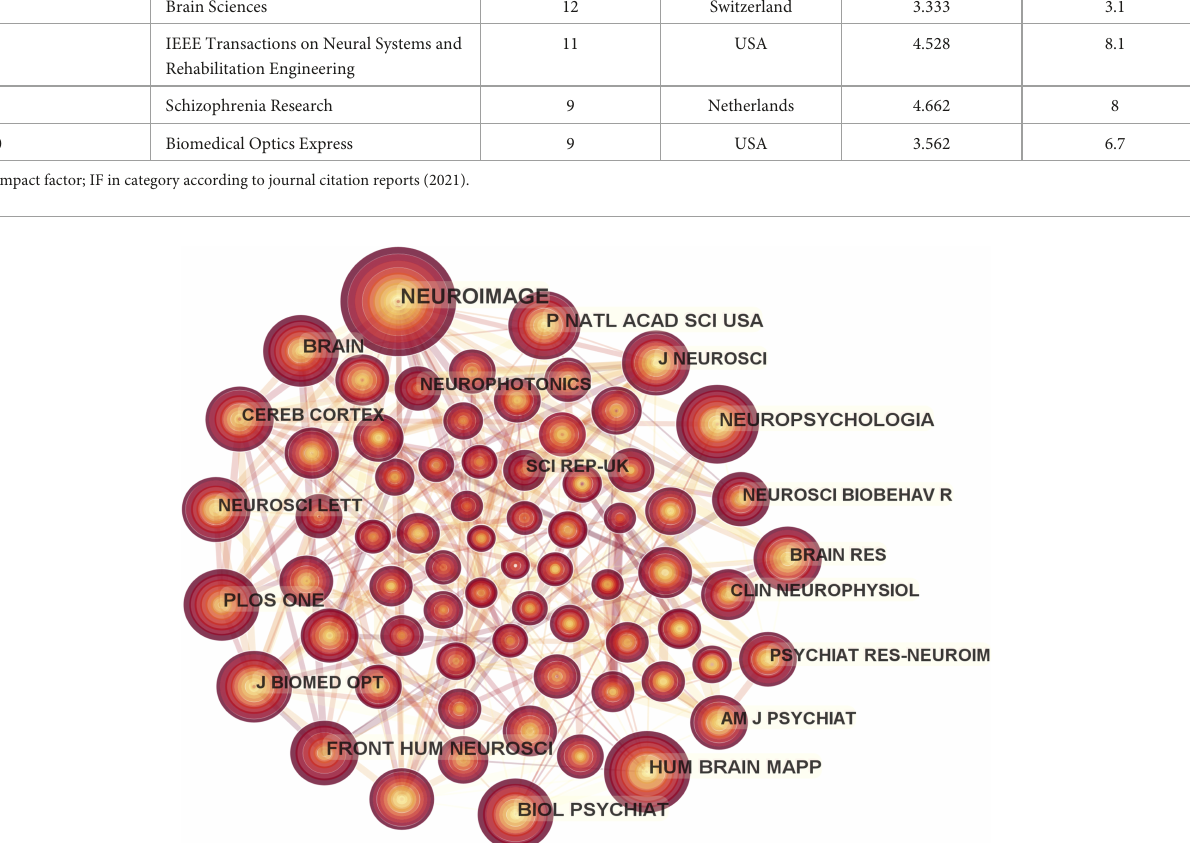
FIGURE6 Map of cited journals in functional near-infrared spectroscopy (fNIRS) research on diseases.